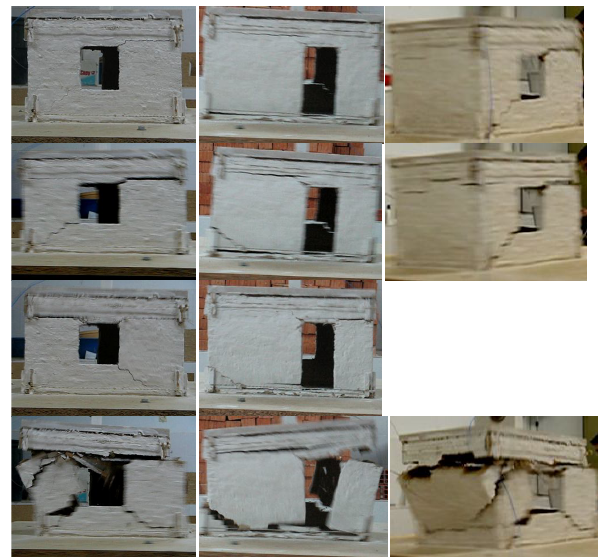
Fig. 25 Failure of Specimen P2 Fig. 25. Failure of specimen